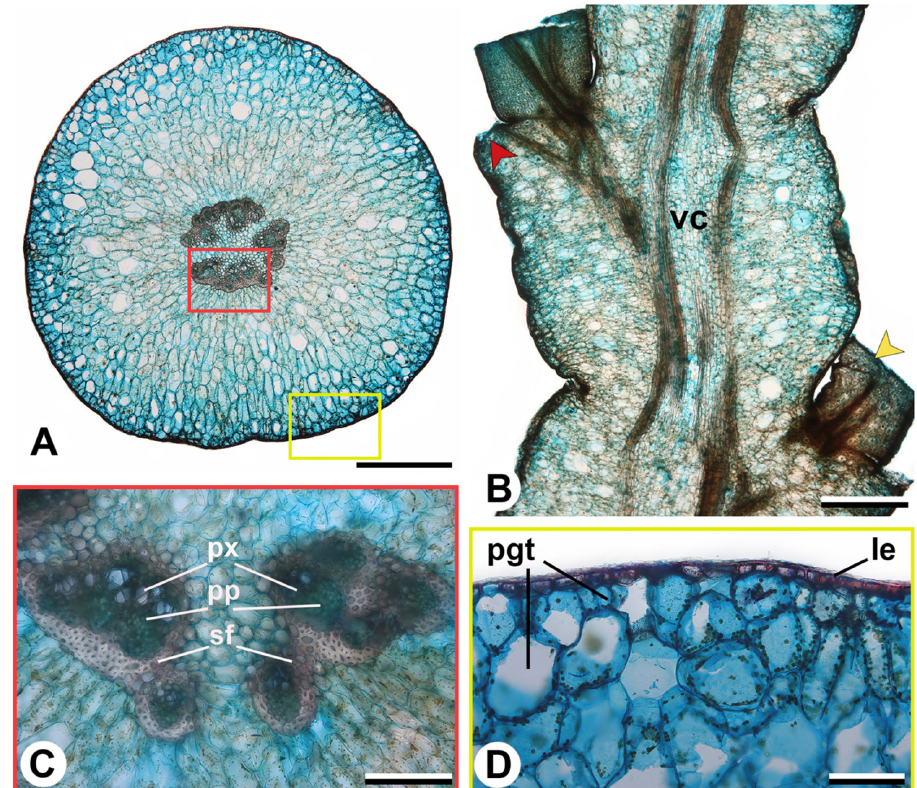
Figure 5. Anatomical structure of the thickened internode of the rachis of C. monilirachis. ( A ) Cross section; ( B ) longitudinal section with removed bracts and rudimentary flowers, red arrow—place of attachment of the removed bract, yellow arrow—base of the ovary of the removed flower; ( C ) closed collateral vascular bundles; ( D ) cross section of the peripheral zone with hypertrophied parenchyma cells. Abbreviations: px, primary xylem; pp, primary phloem; sf, sclerenchyma fiber; pgt, parenchymatous ground tissue; le, lignified epidermis; vc, vascular cylinder. Scale bars: ( A , B ) = 1 cm; ( C ) = 0.2 mm; ( D ) = 0.1 mm.